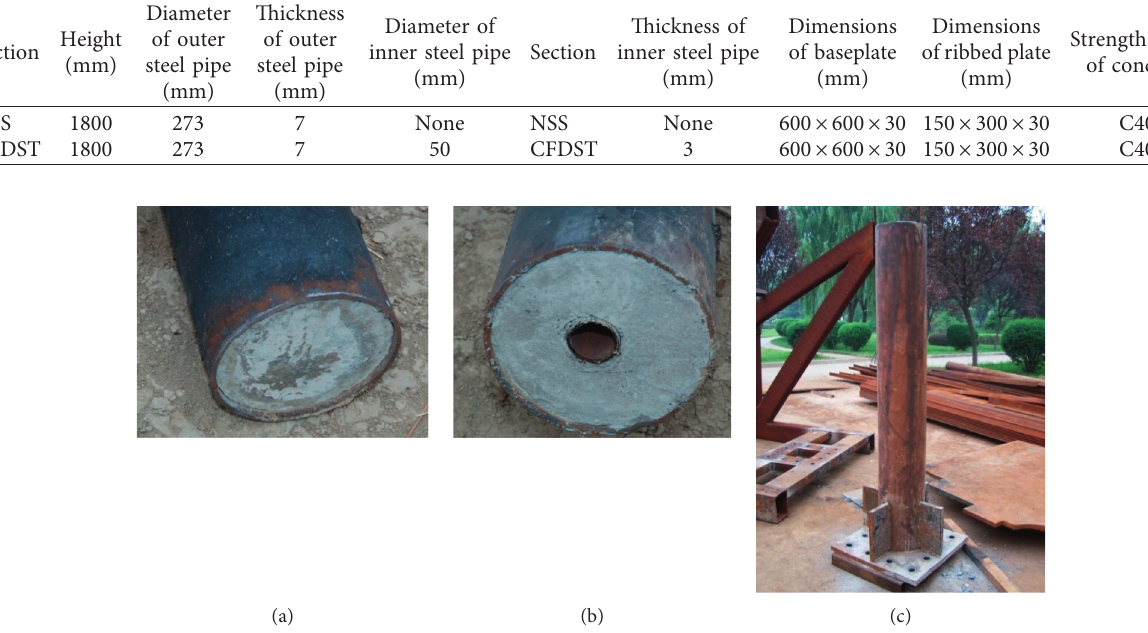
Figure 2: Photographs of specimens. (a) NSS. (b) CFDST section. (c) Overall image of